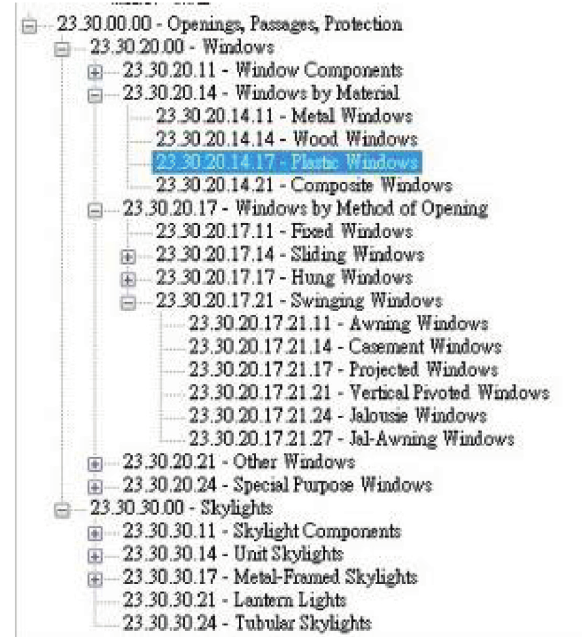
Figure 4: The window system coding in OmniClass (source: Autodesk Revit 2016) [20].